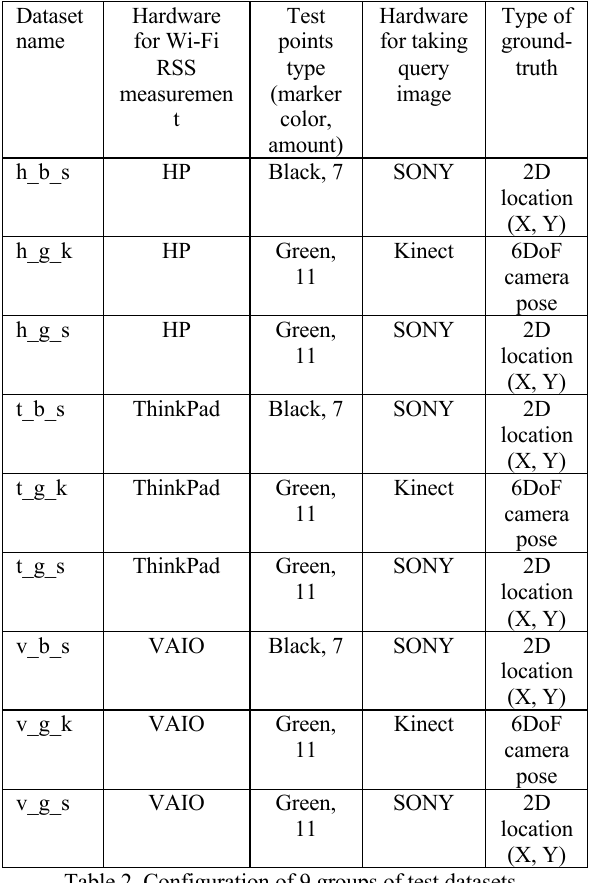
Table 2. Configuration of 9 groups of test